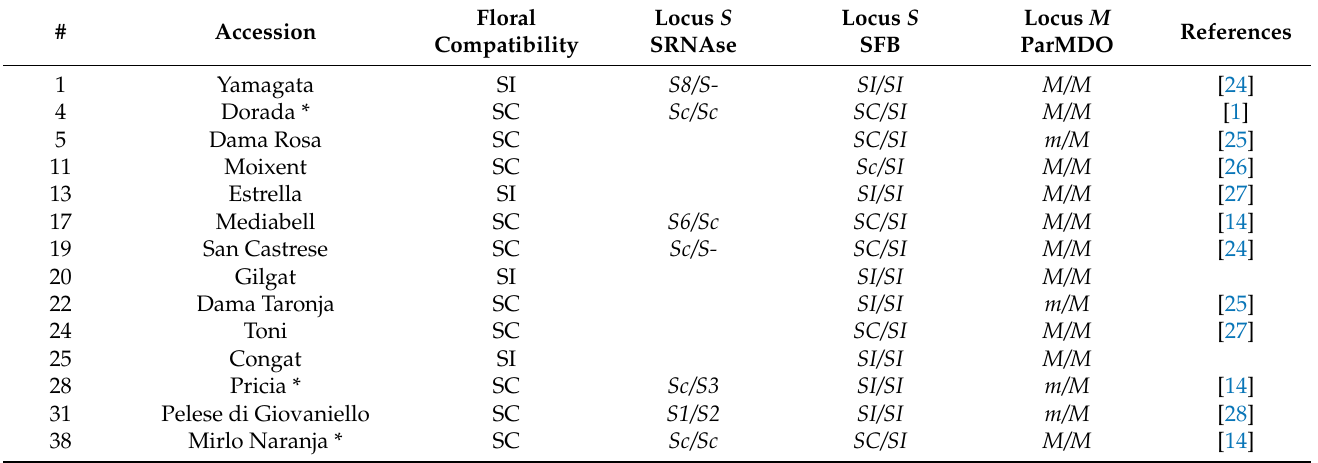
Table 1. List of accessions used for locus S and M HRMA assays development and validation. Genotype (also including S-RNAse alleles as reported in literature), phenotype and related references are indicated. Locus S and M alleles obtained in this work are listed in Locus S SFB and Locus M ParMDO columns respectively. *Asterisks marks accessions in disagreement with previous literature